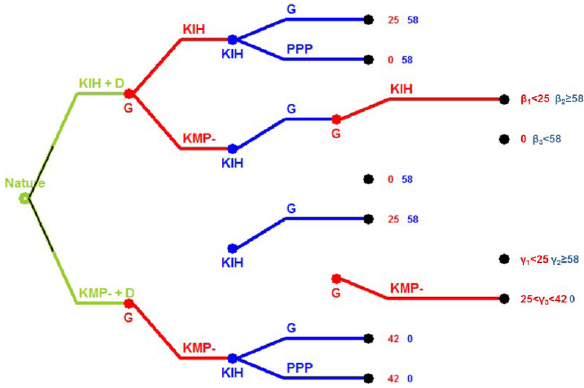
Figure 1: Game Tree of Political Bargaining